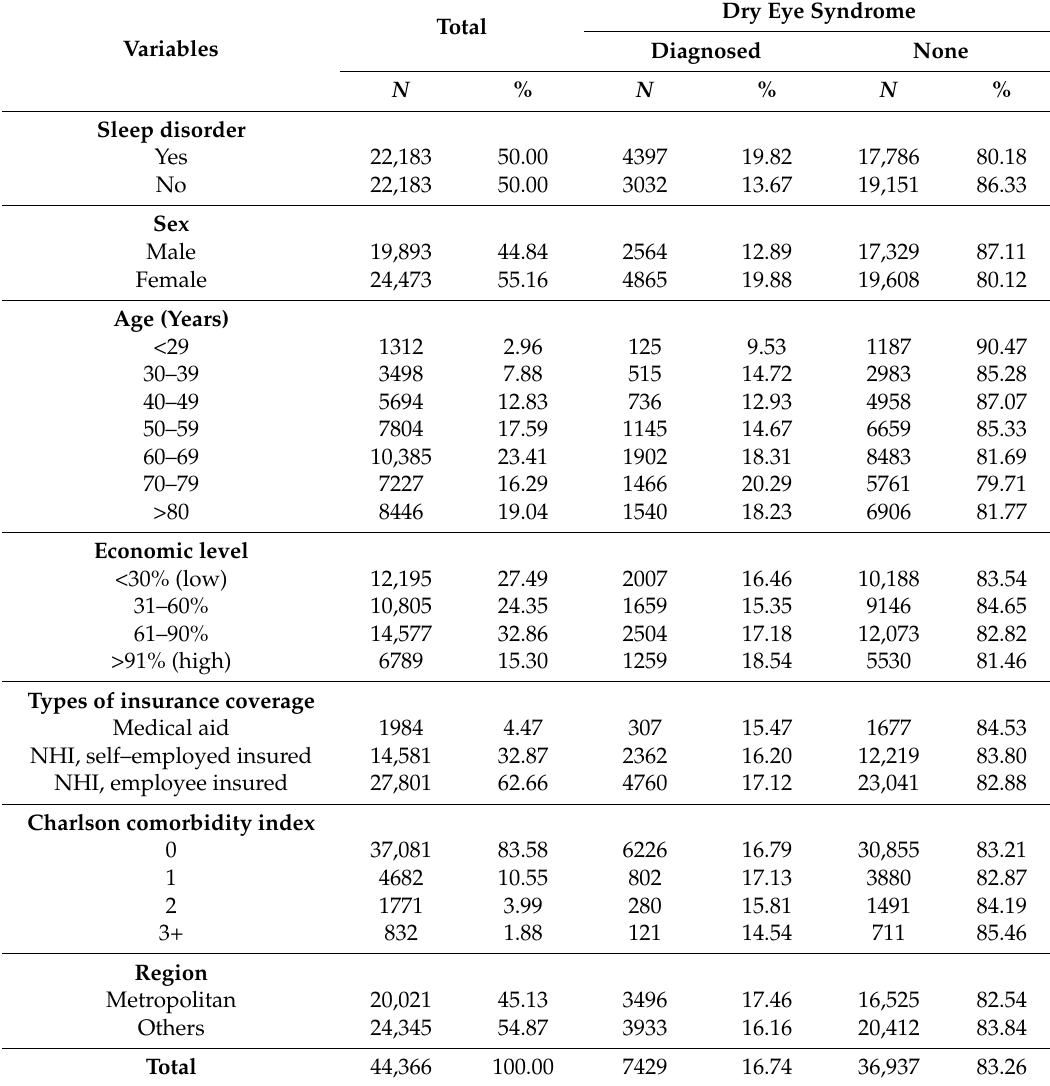
Table 1. General characteristics of the study population.